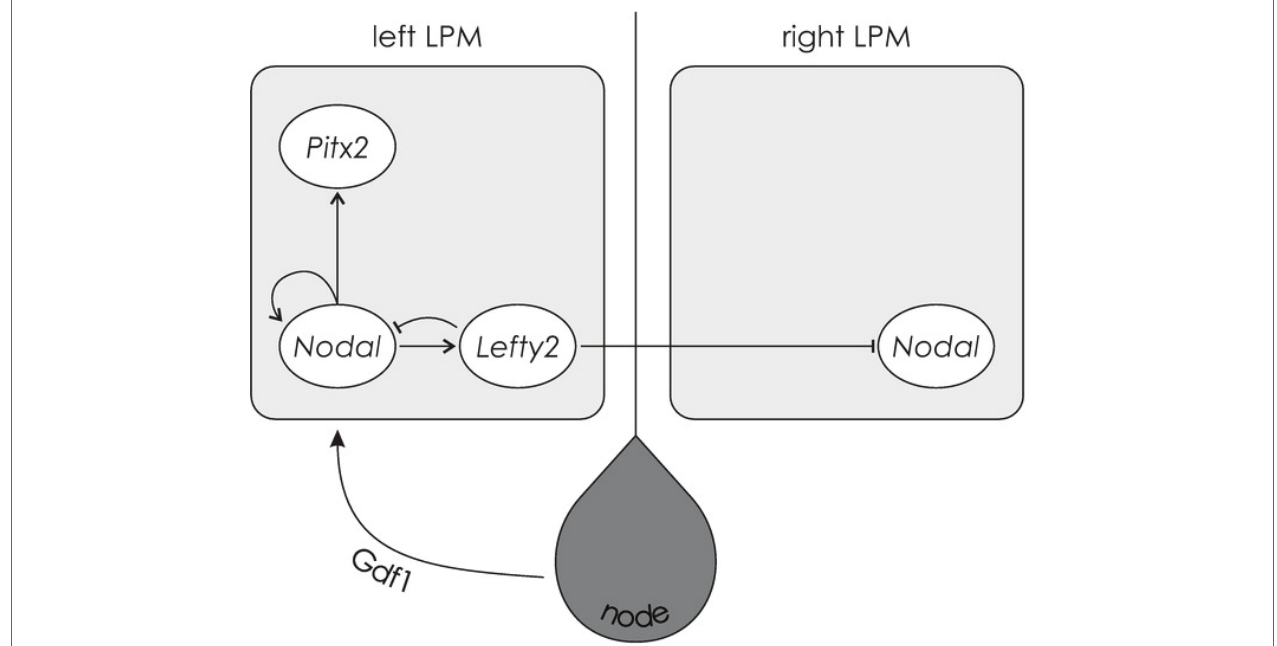
FIGURE 4 | The Nodal signaling cascade. Facilitated by Gdf1, Nodal is transmitted to the left LPM, expressing Nodal , Lefty2 , and Pitx2 . The protein encoded by Lefty2 suppresses the Nodal pathway in the right LPM. Pitx2 encodes a transcription factor that is involved in asymmetric